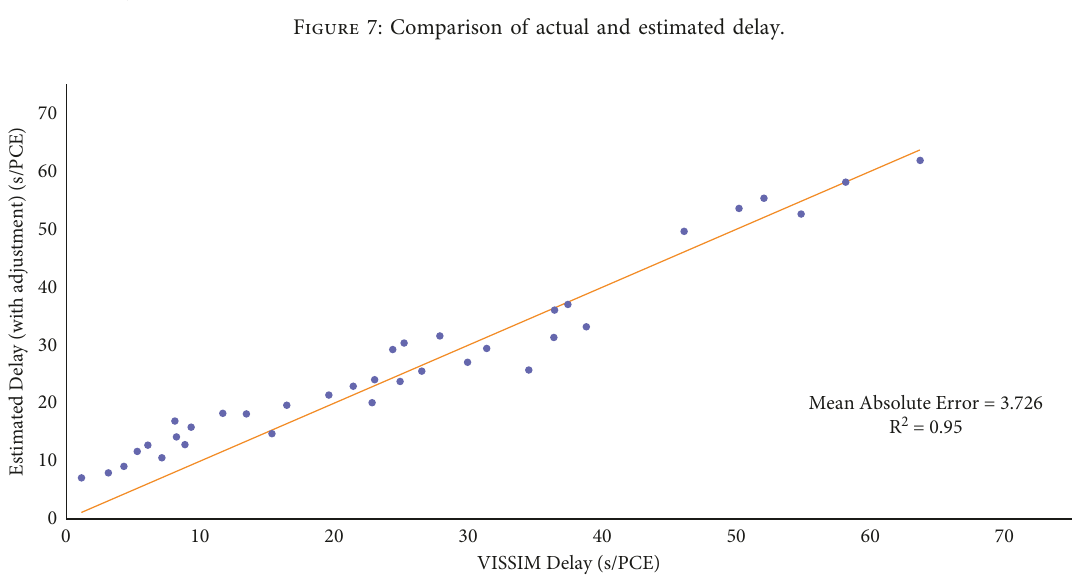
Figure 7: Comparison of actual and estimated delay.